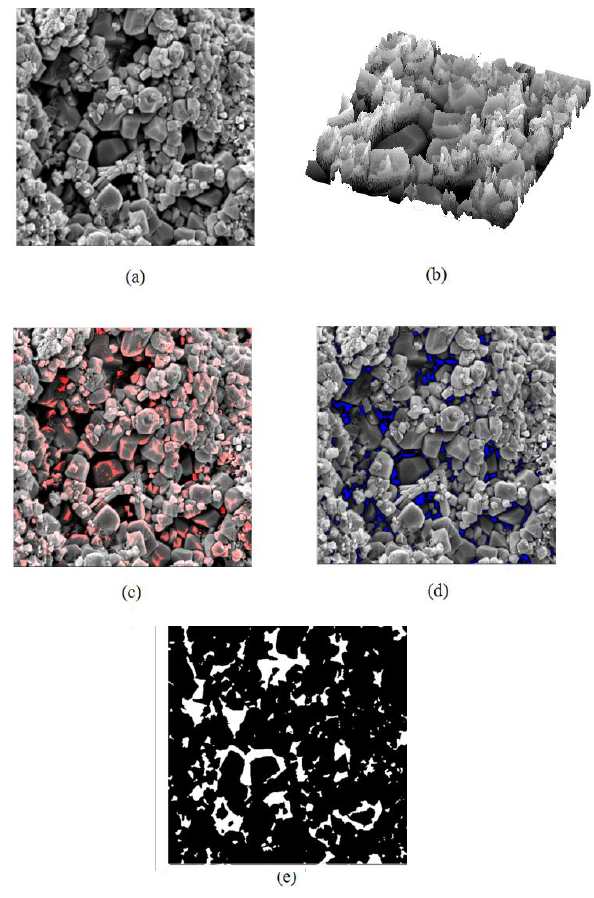
Fig. 4. Watershed segmentation with markers for pores and grains: Figure 4. Watershed segmentation with markers for pores and grains: a) Grey levels input 3 (a) Grey levels input image, (b) 3-D visualization of image in relief, (c) Grains detected markers in red, (d) Pores detected markers in image, b) 3D visualization of image in relief, c) Grains detected markers in red, d) Pores 4 blue, (e) Final segmentation result: black pixels denote grains and detected markers in blue, e) Final segmentation result: black pixels denote grains and white 5 white denote pores. denote pores. 6